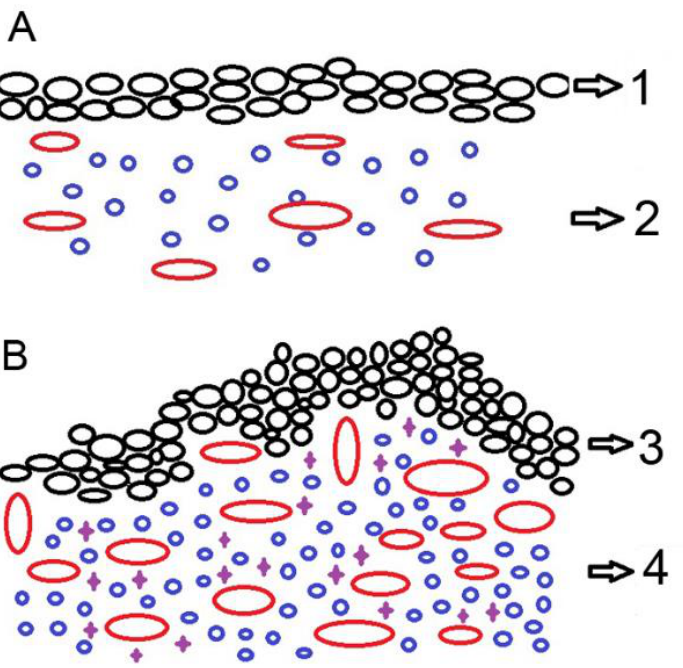
Figure 1. Schematic drawing of synovial membrane of patients with moderate ( A ), and severe ( B ) hip osteoarthritis (HOA). The epithelial lining (black circles) represents intima and stroma underneath represent subintima; 1—synovial surface lined by moderate hyperplasia of synovial cells (black circles); 2—underlying stroma with moderate amount of lymphocytes (blue circles) and blood vessel proliferation (red circles); 3—severe hyperplasia of synovial cells (black circles) in a papillary pattern; 4—underlying stroma with abundant lymphocytes (blue circles), macrophages (violet crosses) and pronounced blood vessel proliferation (red circles).